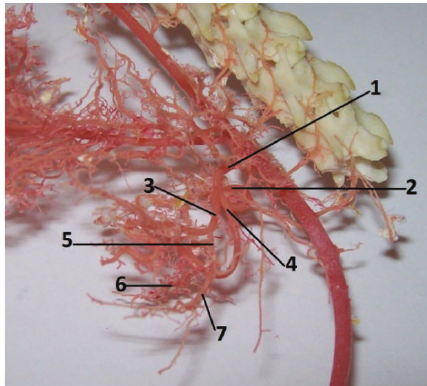
Figure 6: The division of the coeliac artery in rat. 1: a. celiaca , 2: a. gastrica sinistra , 3: a. hepatica , 4: a. lienalis , 5: a. gastroduodenalis , 6: a. gastroepiploica dextra , and 7: a. pancreaticoduodenalis cranialis (casting medium Duracryl